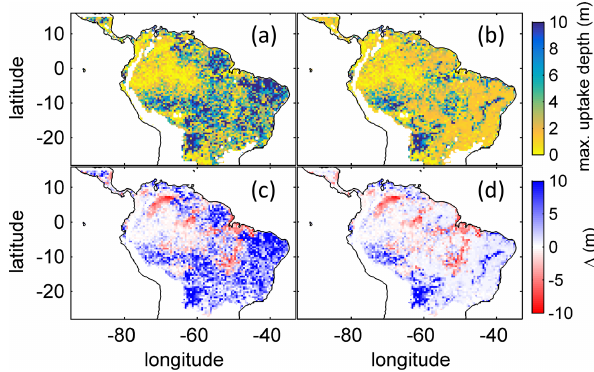
Figure B4. Comparison of simulated D 95 to product of maximum tree root water uptake depth (MDRU). (a) Original (Fan et al., 2017) MDRU regridded to 0.5 ◦ × 0.5 ◦ resolution of LPJmL4.0-VR. (b) Same as (a) but adjusted to soil depth input used in this study (see Sect. 2.3.2), in cases where values of Fan et al. (2017) ex- ceeded this soil depth. The colour-scale maximum for (a) and (b) is set to 10m. (c) Difference between (a) and D 95 simulated with LPJmL4.0-VR under CRU climate forcing (Fig. 2a). (d) Difference between (b) and D 95 simulated with LPJmL4.0-VR under CRU cli- mate forcing (Fig. 2a). Red/blue colours denote higher/lower root- ing depths in LPJmL4.0-VR.